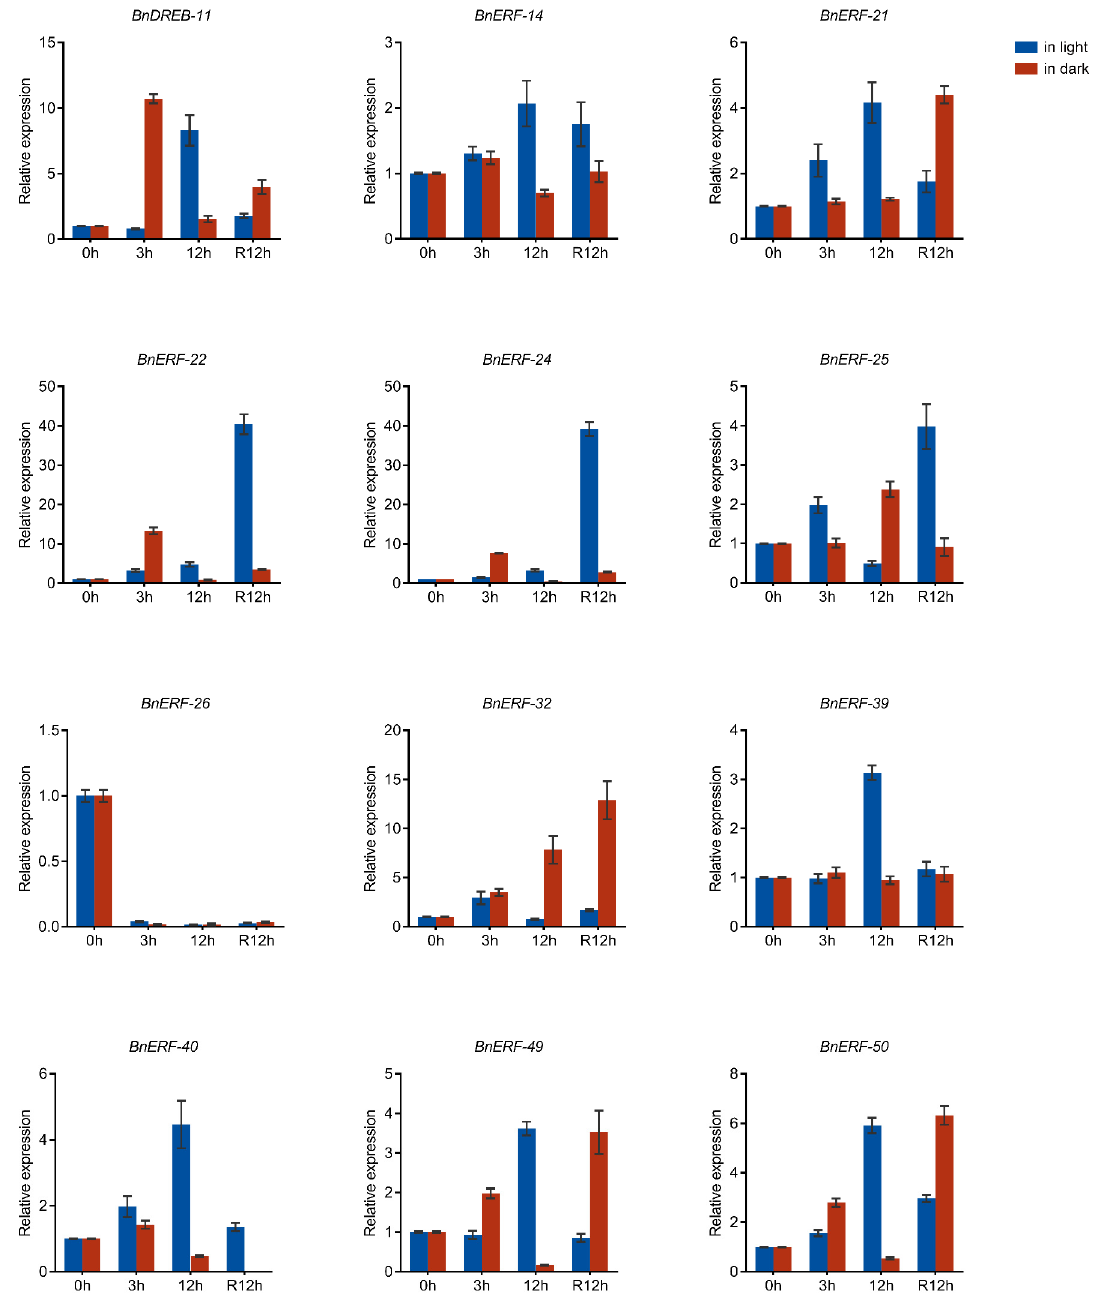
Figure 10. The qPCR results of selected BnAP2/ERF genes in ramie leaf samples at 0, 3, and 12 h after waterlogging, and at 12 h (R12h) recovery to normal growth condition. The blue and red bars represent the relative expression level of BnAP2/ERF genes of ramie under light and dark conditions, respectively. The error bars represent the standard deviation of three biological duplicates.